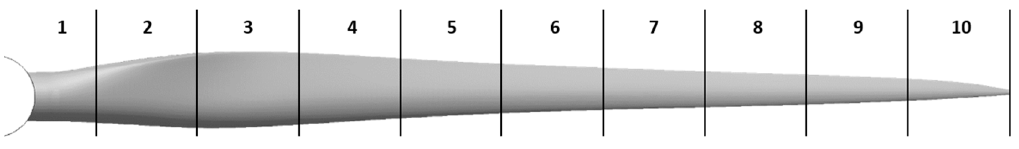
Figure 5. Illustration of the used blade strips.